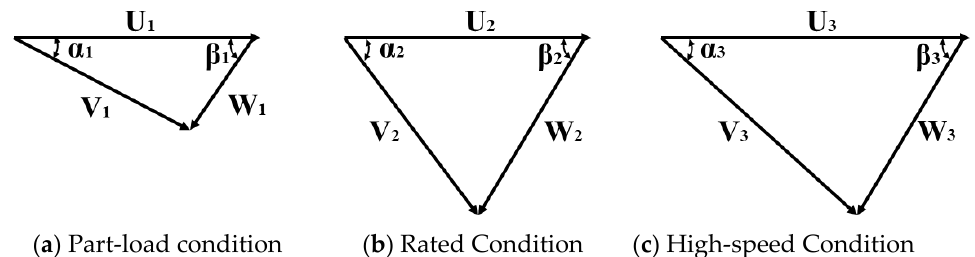
Figure 10. Velocity triangle. Note: α 1 , α 2 and α 3 are the absolute flow angles at the inlet ( ◦ ); β 1 , β 2 and β 3 are the relative flow angles at the inlet ( ◦ ); U 1 , U 2 and U 3 are circumferential speeds (m/s); W 1 , W 2 and W 3 are relative velocities (m/s); and V 1 , V 2 and V 3 are absolute velocities (m/s).